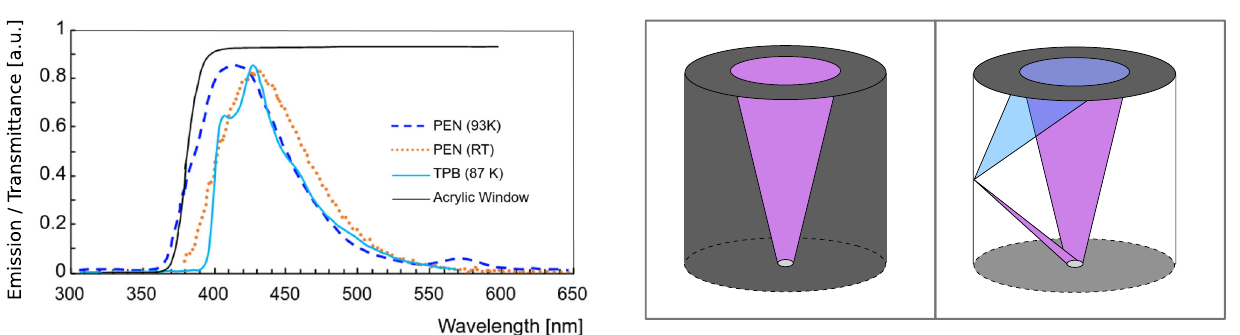
Fig. 13 Transmittance of the acrylic window and emission spectra of TPB at 87K [26], of PEN at 93K [52] and at RT (this work) lengths above 50 µ m for PEN and 2 . 0 µ m for TPB 14 (mini- mum value from [51]) did not yield significant changes.